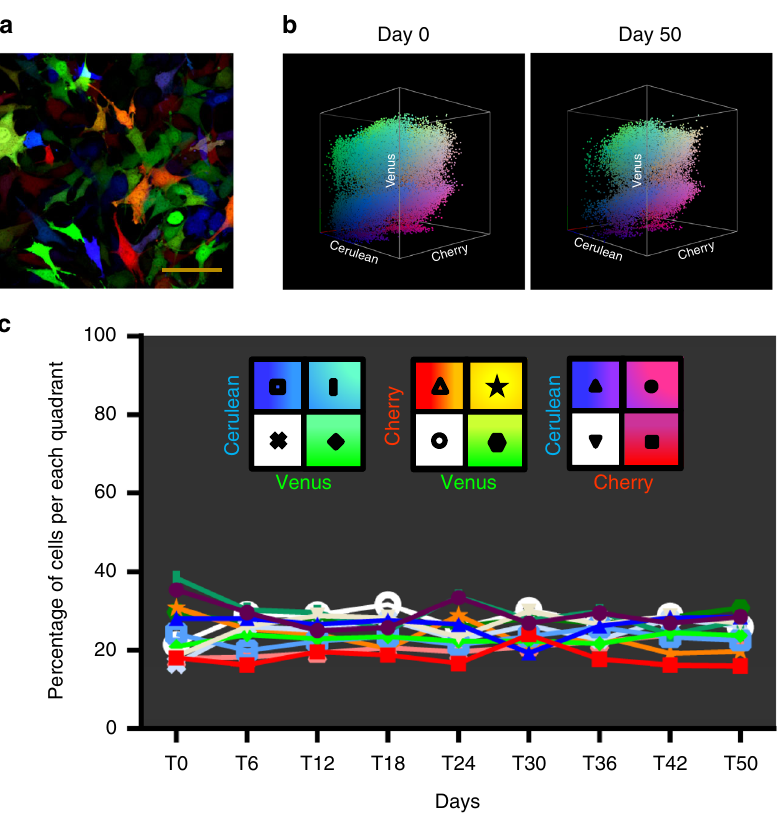
Fig. 1 RGB marking of RAINBONE cells is stable during in vitro culture. a Representative confocal microscopy image of the optimal colour mixture. Orange bar = 100 µ m. b Representative 3D fl ow cytometry analysis of RAINBONE cells at day 0 (left) and day 50 (right) of in vitro culture. c Quanti fi cation of the